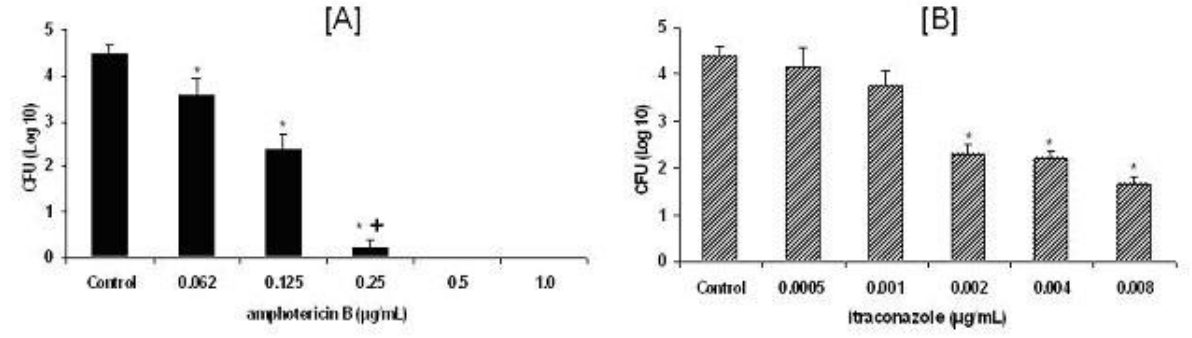
Figure 1. Viable yeast cells obtained from cultures with different ( A ) amphotericin B or ( B ) itraconazole concentrations. The results are expressed as mean log 10 CFU/mL from ten independent